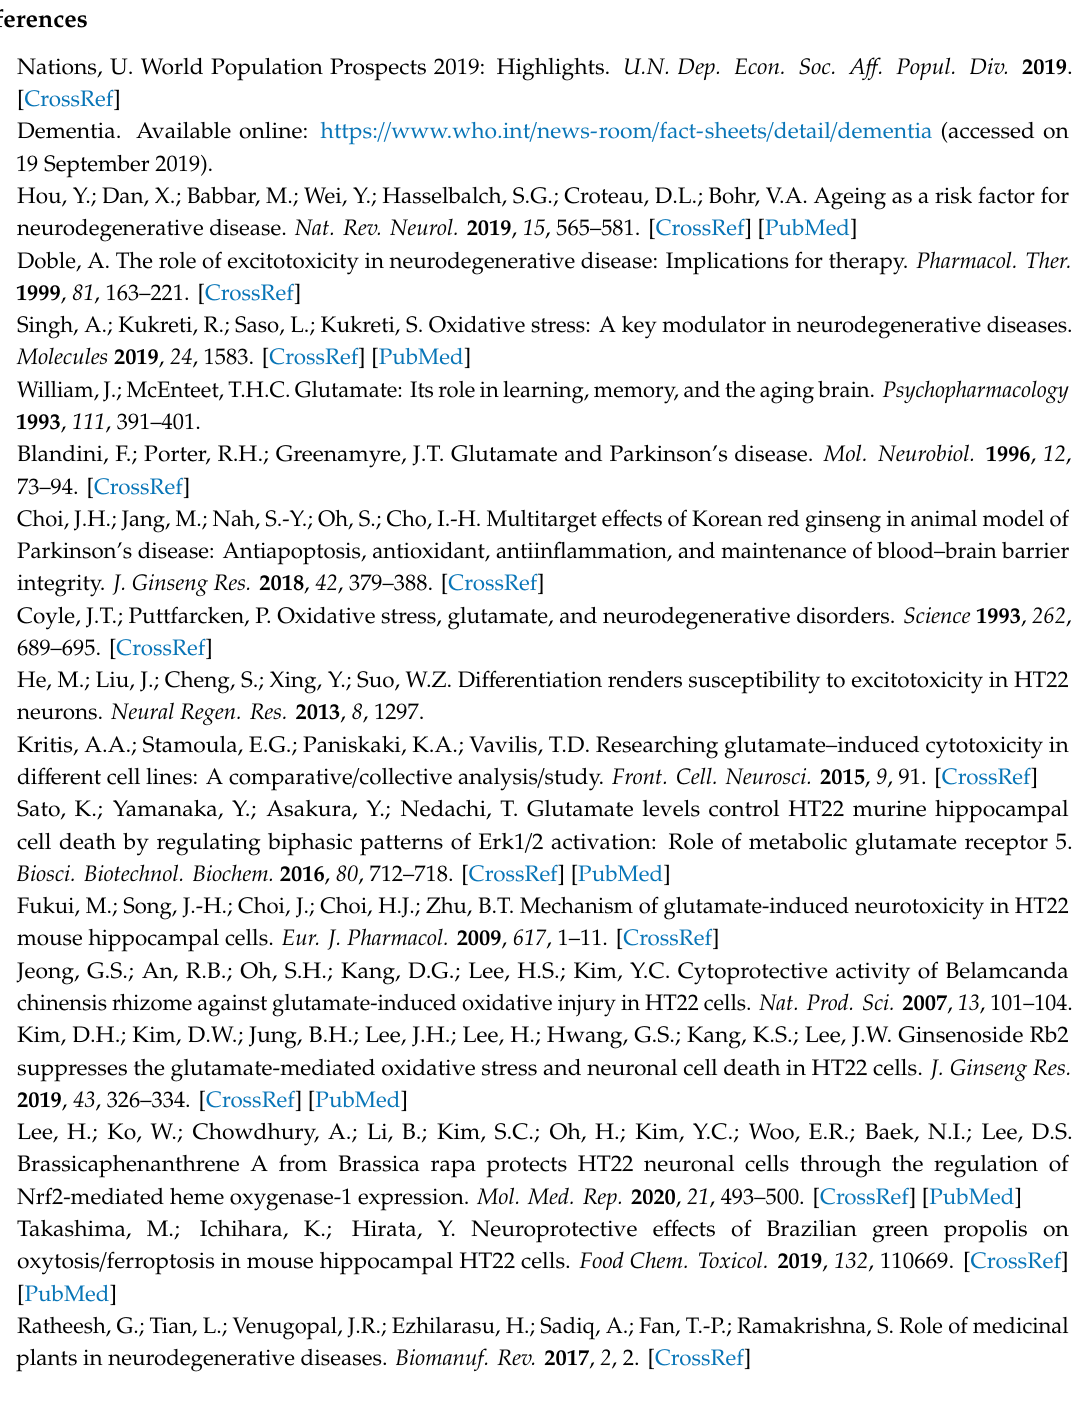
Figure S1: Information of antibodies used for western blotting., Table S1: Information of antibodies used for western